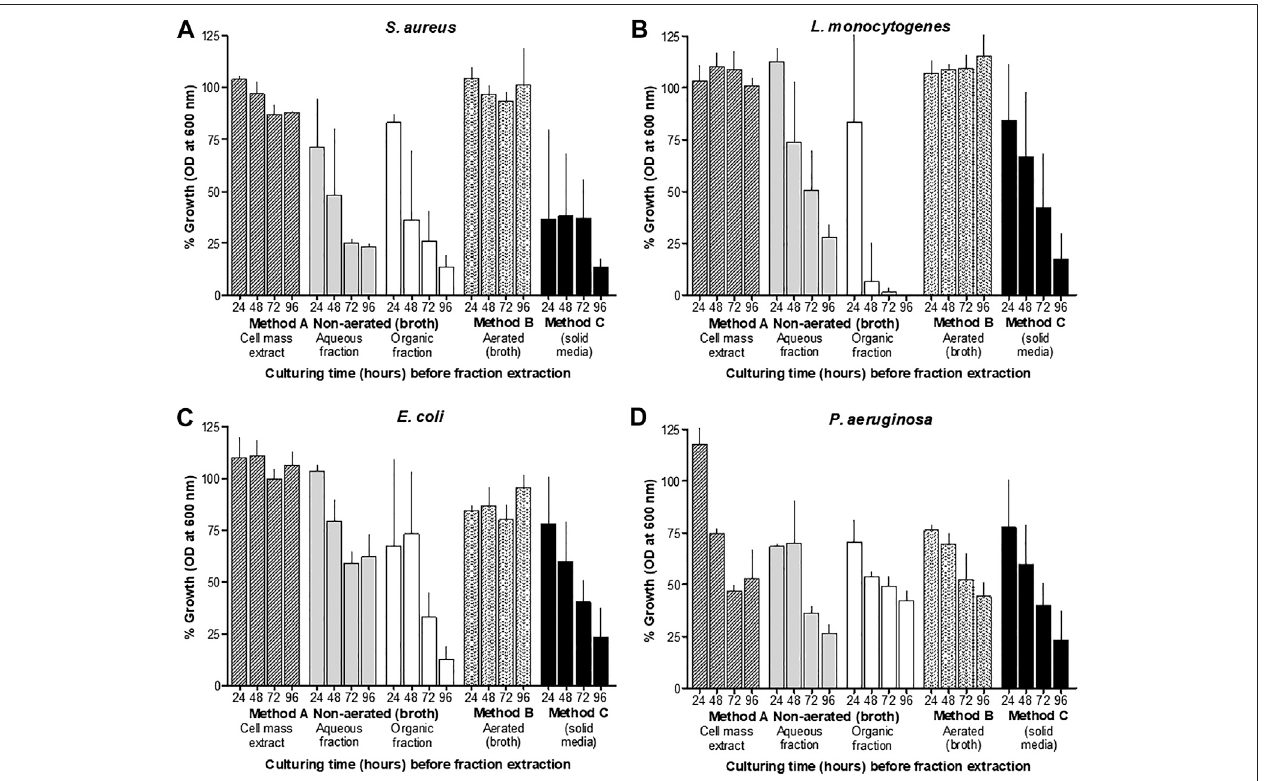
FIGURE2| Growthinhibition(%)ofdifferenttargetbacteria ,S.aureus (A) ,L.monocytogenes (B) ,E.coli (C) andP.aeruginosa (D) , asobservedbychangesinOD at 600 ± 5 nm, compared to control cultures, after exposure to the fi ve different X. khoisanae J194 culture extracts. The response (OD at 600 nm) of the selected target bacteria S. aureus ATCC 25923, L. monocytogenes EDGe, E. coli Xen 14 and P. aeruginosa ATCC 27853, are shown after 24 h exposure to extracts and incubation at 37 ° C.Threeculturesofeachtargetorganismweretreatedwithcell-freesupernatants(CFS)of X.khoisanae J194culturedinnon-aeratedbroth(MethodA),aerated broth(MethodB)andonthesurfaceofsolidmedia(MethodC),respectively.CFSsofnon-aeratedculturewereseparatedintotheacetonitrile(NAA)andorganicfractions (NAO) (Method A). The hours indicated in the graphs refer to the time at which CFSs were collected and freeze-dried.